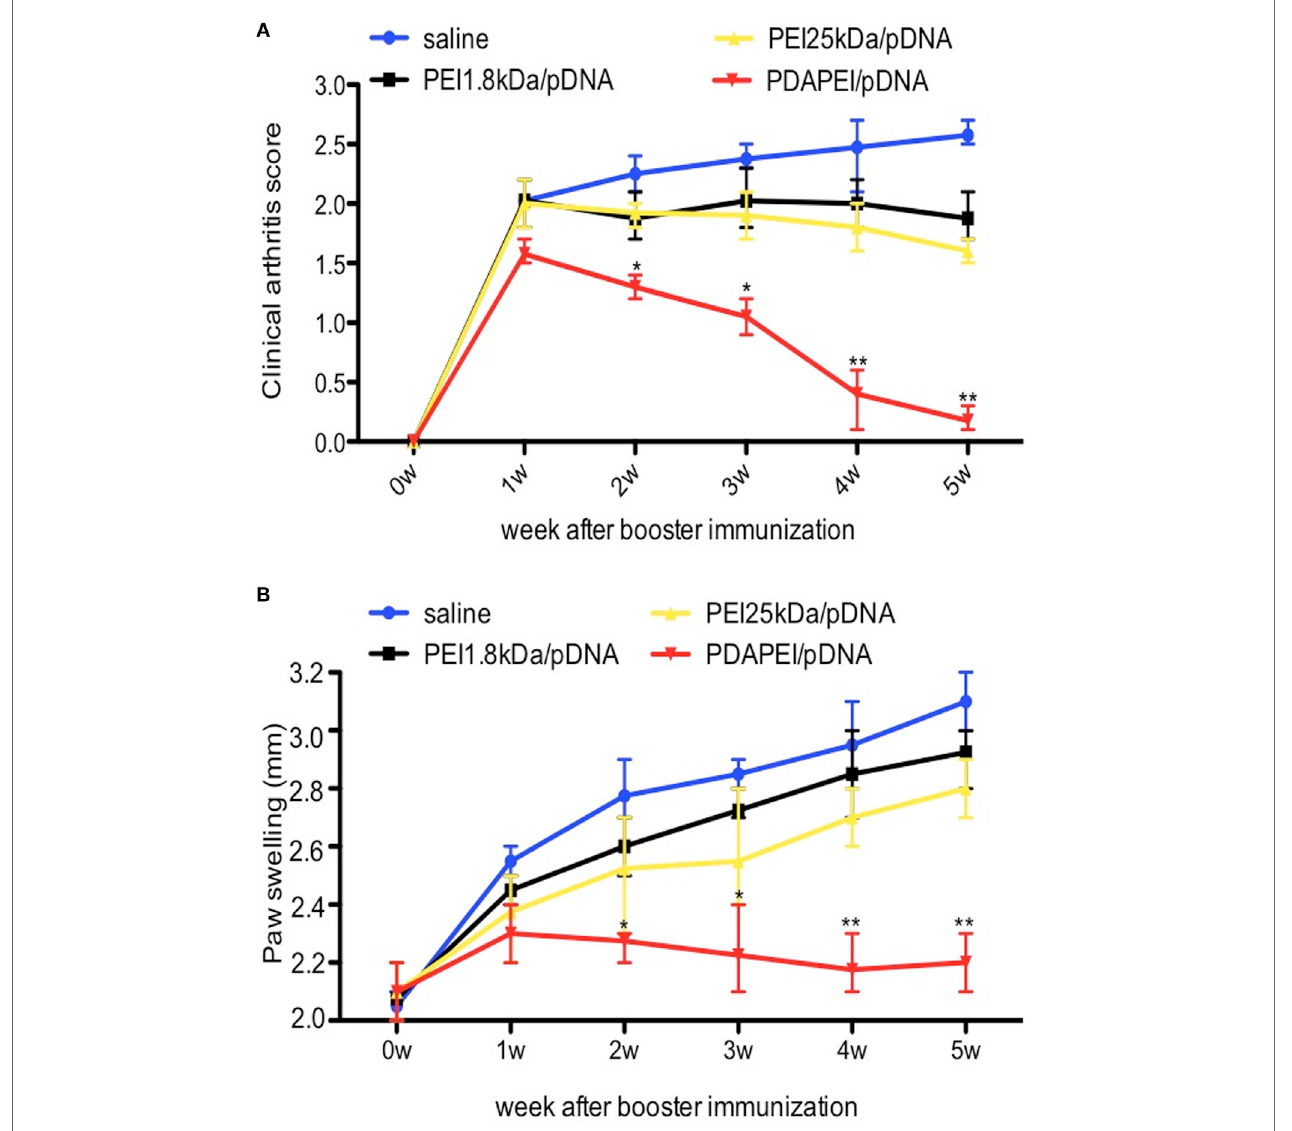
FigUre 5 | clinical scores of arthritis symptoms . (a) Clinical arthritis score. (B) Paw swelling. Data were monitored every week after booster immunization, presented as mean ± SEM ( n = 6 in each group, * p < 0.05, ** p <